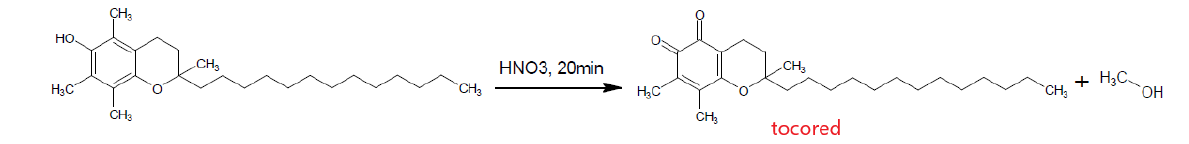
Figure 6. Formation of Tocored with Nitric Acid.